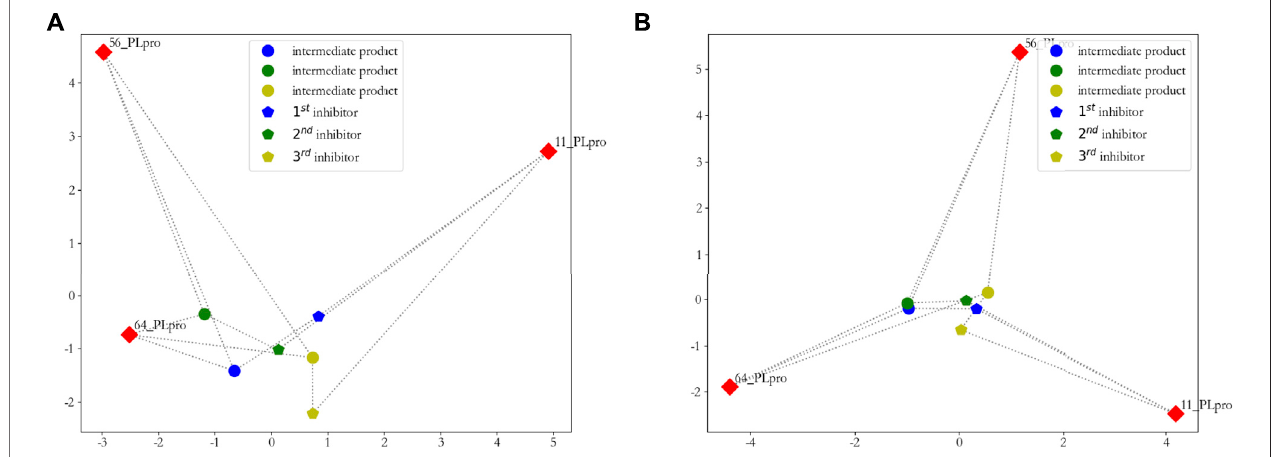
FIGURE7| Two-dimensionalvisualizationofinhibitors. (A) principalcomponentanalysis(PCA)isusedtoreducethedimensionalityofthedistancematrix,whichis calculated from these three new inhibitors, intermediate products, and original seeds; (B) sparse principal component analysis (SPCA) is used to reduce the dimensionality of the distance matrix, which is calculated from these three new inhibitors, intermediate products, and original seeds.